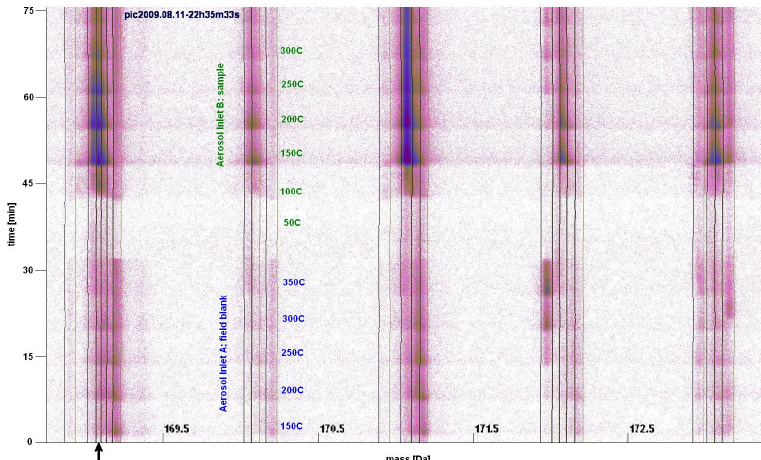
Figure D2. Image of raw TOF-MS data covering the signals of five nominal masses (169-173 Da) over a 75 minute period starting on August 11, 2009 at 22:35. The data show measurements of an aerosol field blank from inlet ‘A’ and aerosol sample from inlet ’B’. The color code scales with the logarithm of the counts detected by the mass spectrometer and covers approximately five orders of magnitude. Also shown as vertical lines are the integration boundaries for the peaks from the ‘unified-peak-list’; the low and high mass margins are printed in black and brown, respectively. Some brown lines are not visible because they are to close to the following black line. The arrow at the x-axis marks the interval of mass 169.085 Da the data of which are also included in the insert of Figure 2.